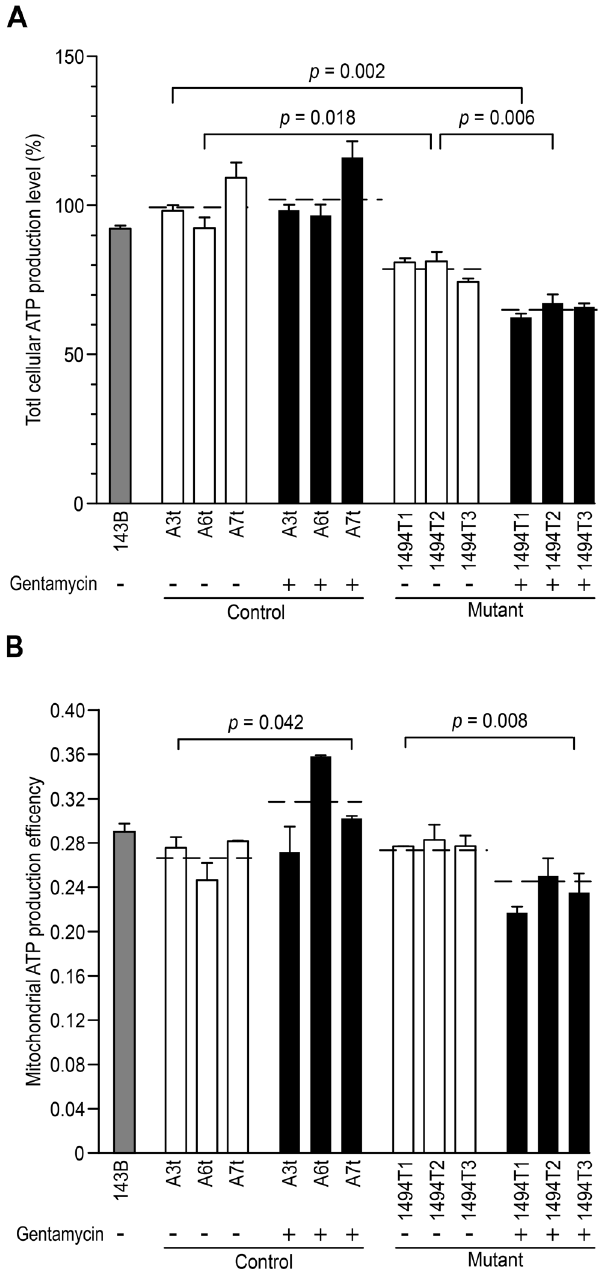
Figure 2. Measurement of cellular ATP production and its efficiency rate. The cells were incubated with 10 mM glucose or 5 mM 2-deoxy-d-glucose plus 5 mM pyruvate to quantify ATP generation through mitochondrial ATP synthesis. The efficiency of ATP production was measured as the mean value of mitochondrial ATP generation vs. the total ATP generation in each cell line. (A) ATP level per cell line. (B) Efficiency of ATP production per cell line. At least three independent experiments were performed. Student’s t test, between the mutant and control cybrids, without ( 2 ) or with ( + ) gentamycin